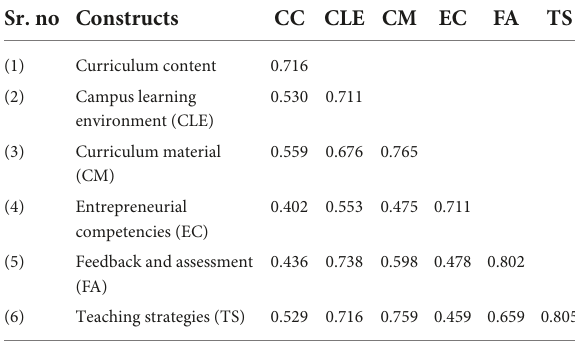
TABLE 3 Discriminant validity